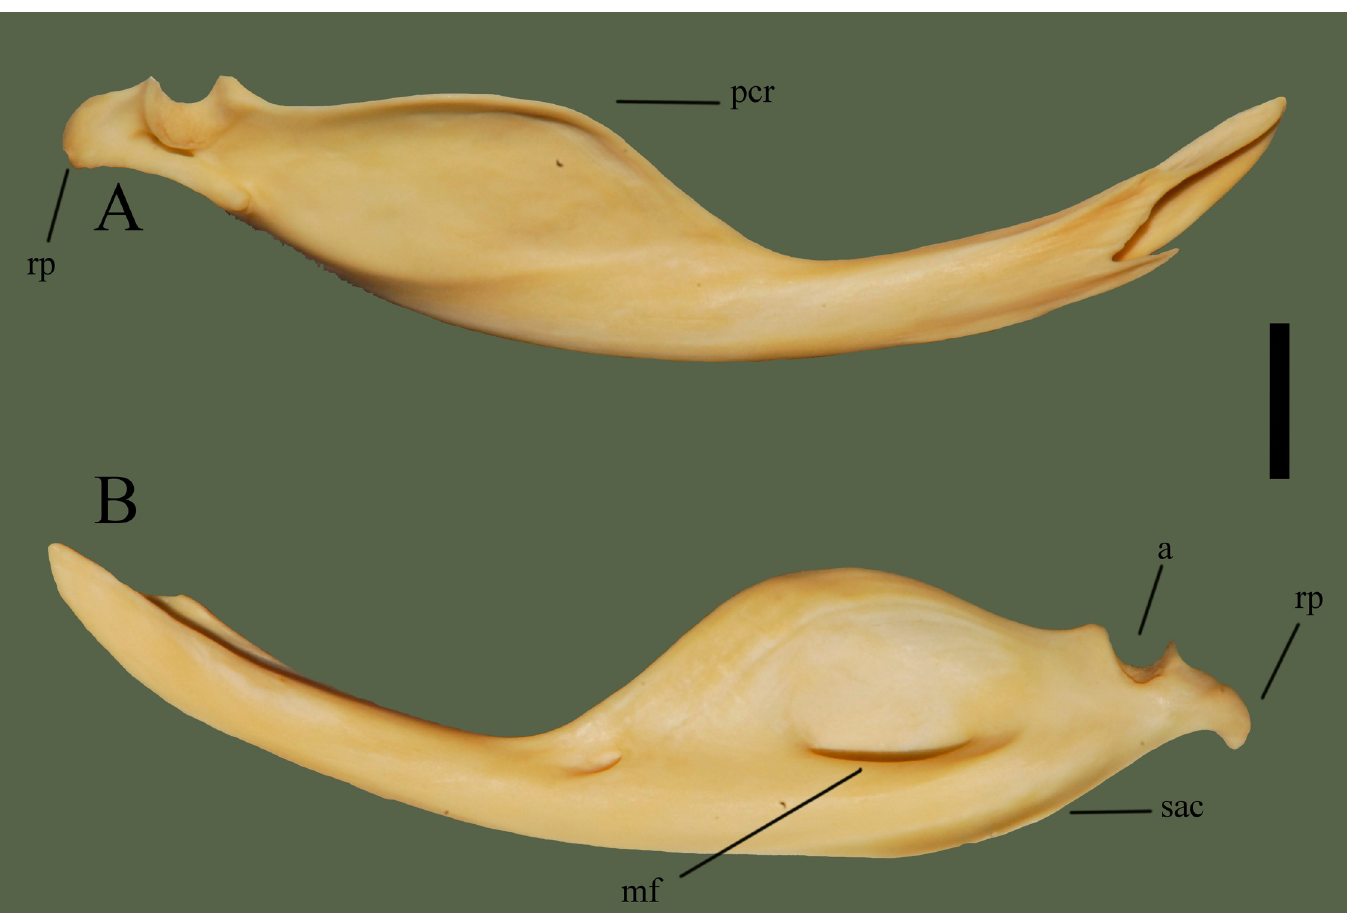
Fig 21. Right compound bone (ETVP 3295) in medial (A) and lateral (B) view. Anterior is to the right for A and to the left for B. Scale bar = 10 mm. Abbreviations: a = articular; mf = mandibular fossa; pcr = prearticular crest; rp = retroarticular process; sac = surangular crest of compound bone.